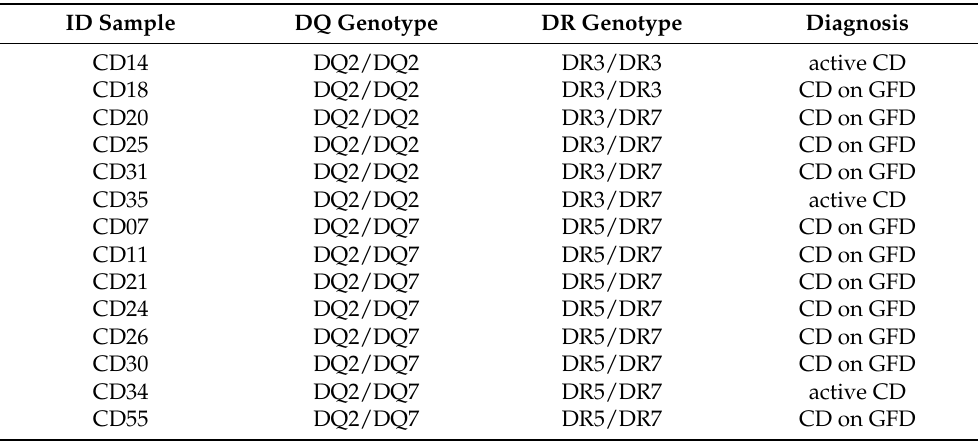
Table 2. HLA-DQ and -DR genotypes of Italian celiac disease patients chosen for macrophages